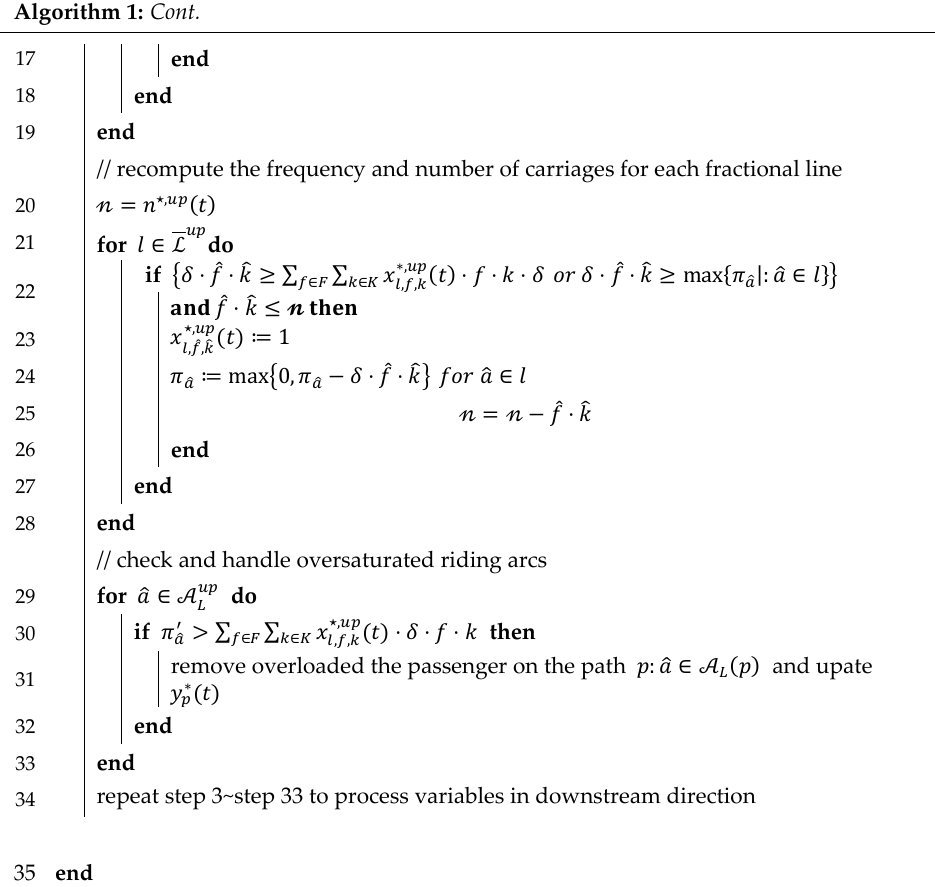
Algorithm 1: Cont.